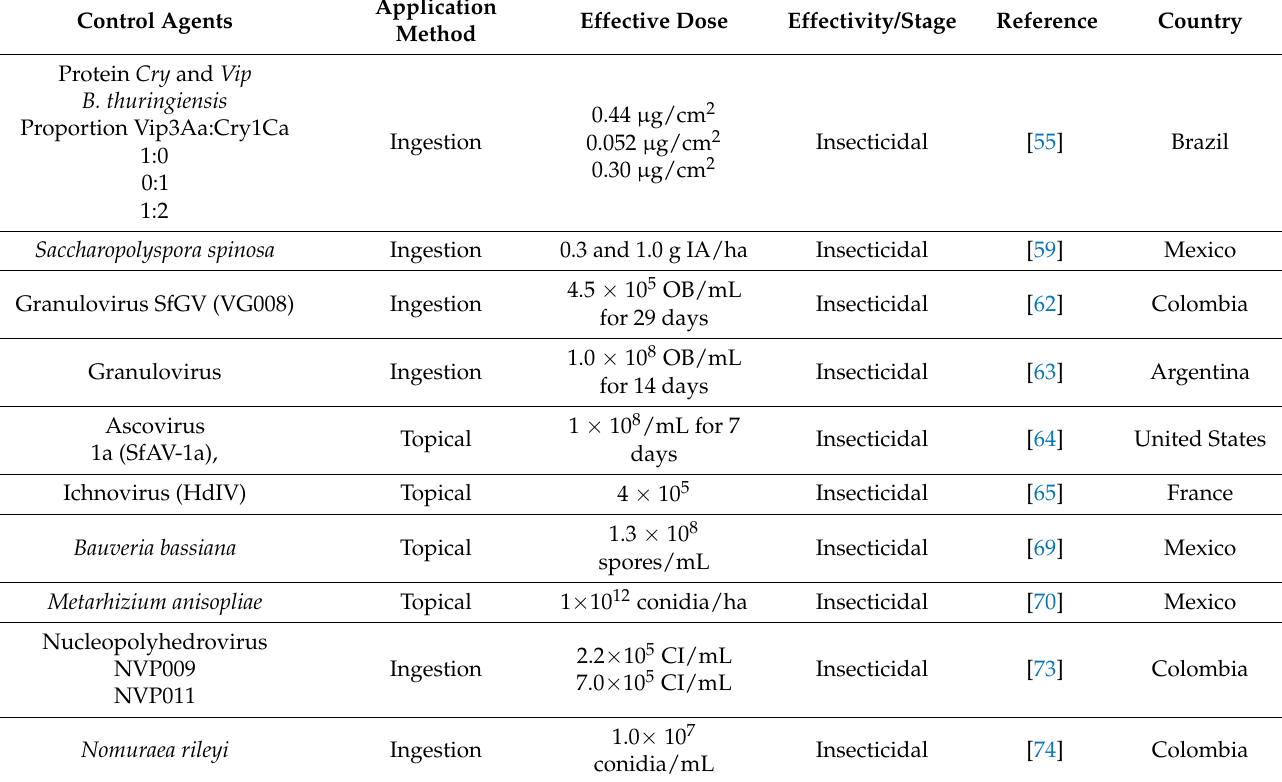
Table 3. Microbial agents with potential insecticidal activity against S. frugiperda